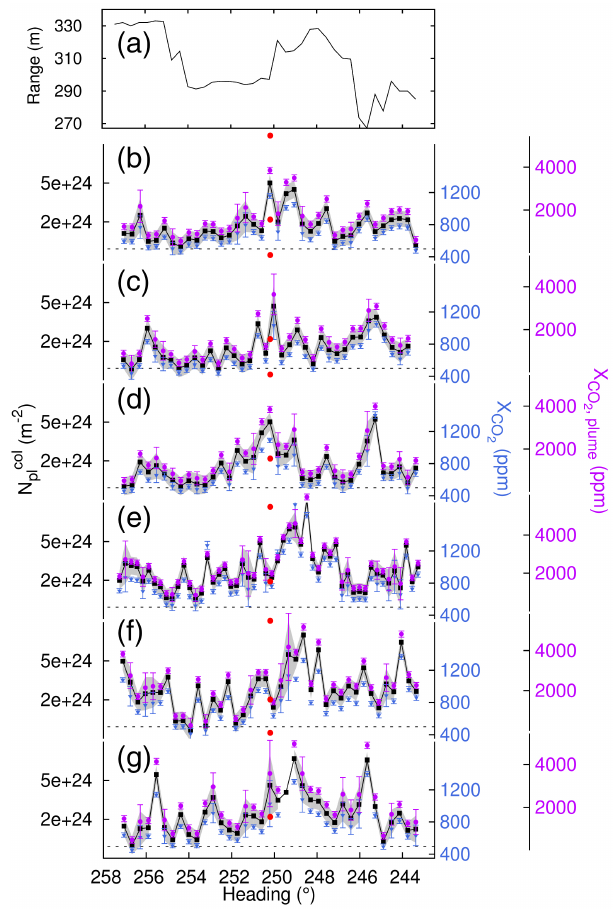
Figure 2. CO 2 concentration profiles of horizontal scans of the Pis- ciarelli fumaroles. (a) Ranges to hard target per heading angle. The target was the slope behind the fumaroles (Fig. 1b and c). (b) – (g) Background-corrected CO 2 column densities versus angle as used for flux computation (Eq. 1). The grey envelope depicts the con- fidence (1 SD; for details see Queißer et al., 2017). On the right are the corresponding path-averaged mixing ratios (blue) with con- fidence interval (1 SD). The dotted line depicts the ambient CO 2 mixing ratio of 499ppm. Also shown are the in-plume mixing ratios (magenta), estimated from the path-averaged mixing ratios, assum- ing 62m plume extension (Queißer et al., 2016a). The red circles mark the minimum and maximum mixing ratio of the same day the measurement took place, registered between 0:00 and midnight in 2h intervals by an in situ station operated by INGV Naples, lo- cated near the center of the scanned area. The scans shown were performed in the order they appear. Their respective acquisition start times were ( b to g ) 17:15:17, 17:19:43, 17:22:48, 17:39:00, 17:43:47, and